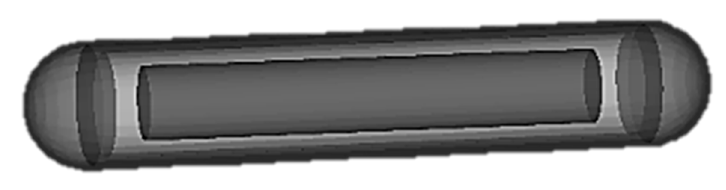
Figure 2. Amersham Oncoseed model in